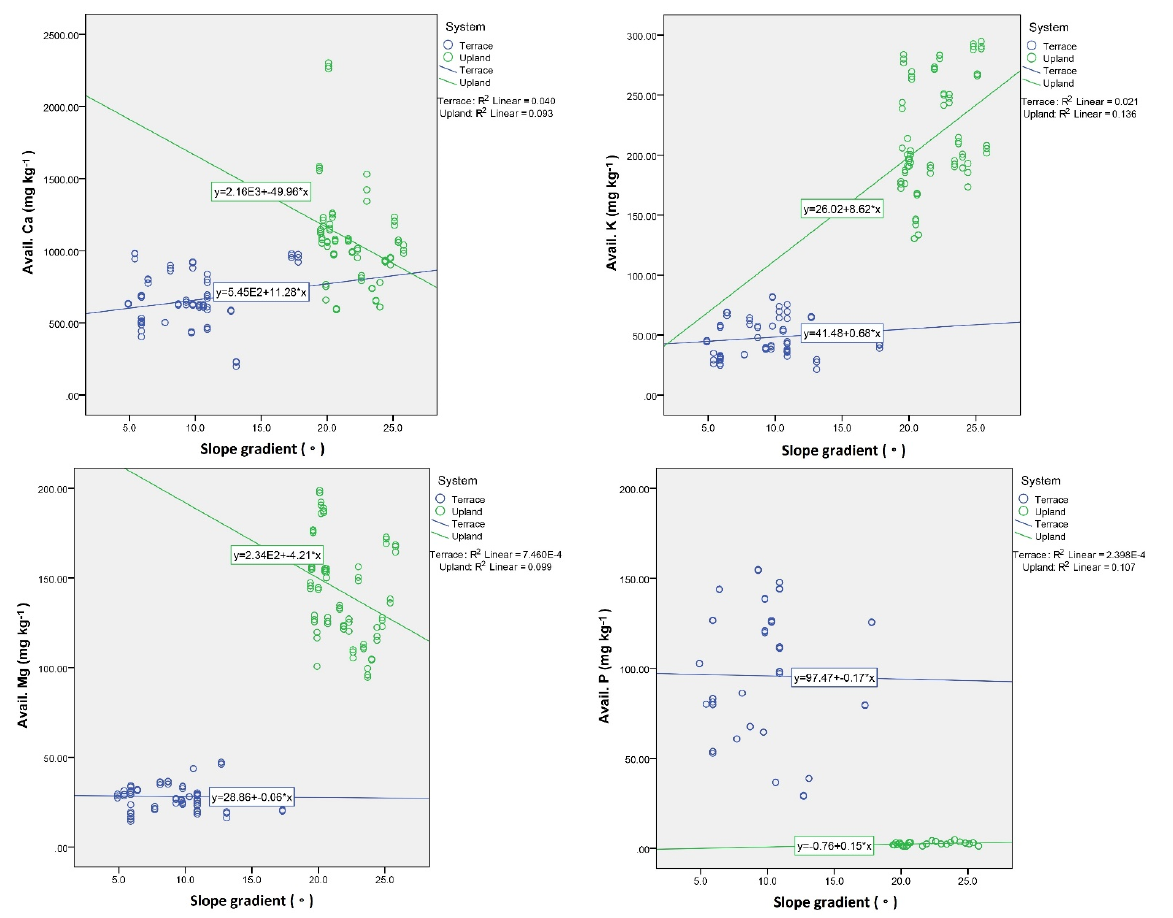
Figure 4. Trend analysis charts of soil physical and chemical properties between terraced paddy field and upland rice. and upland